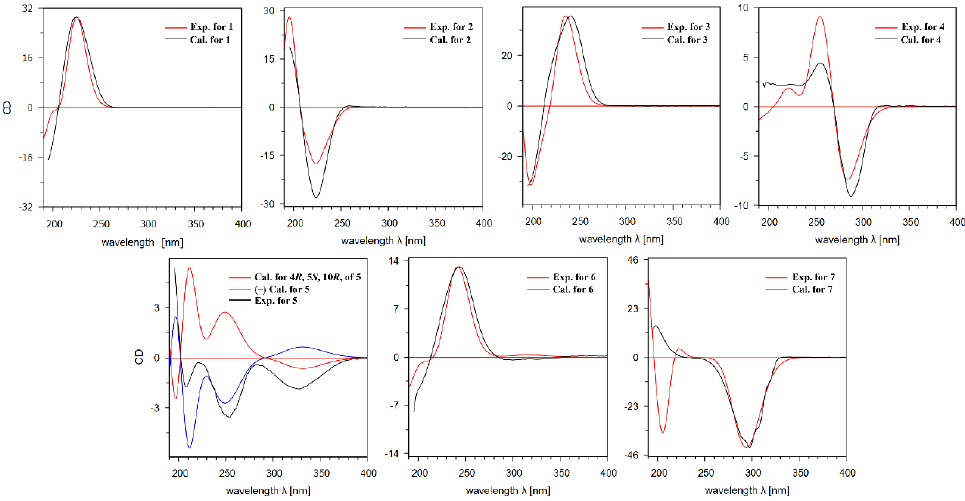
Figure 4. Experimental and calculated ECD spectra of compounds 1 – 7 .